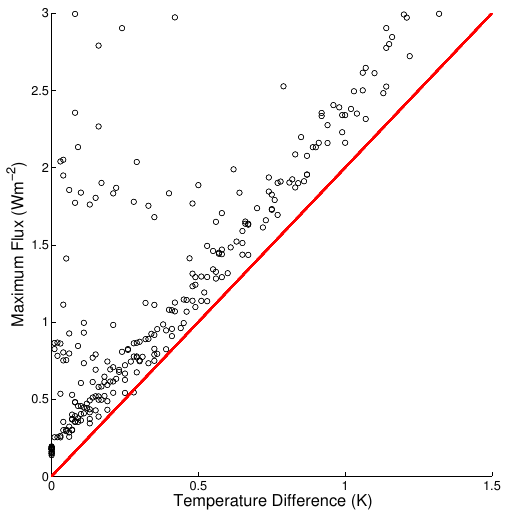
Figure 3. Error Estimate. Maximum flux above the tropopause ( ∆ F ) as a function of difference in surface temperature ( ∆ T ). Red line has slope of ∆ F = 2∆ T .